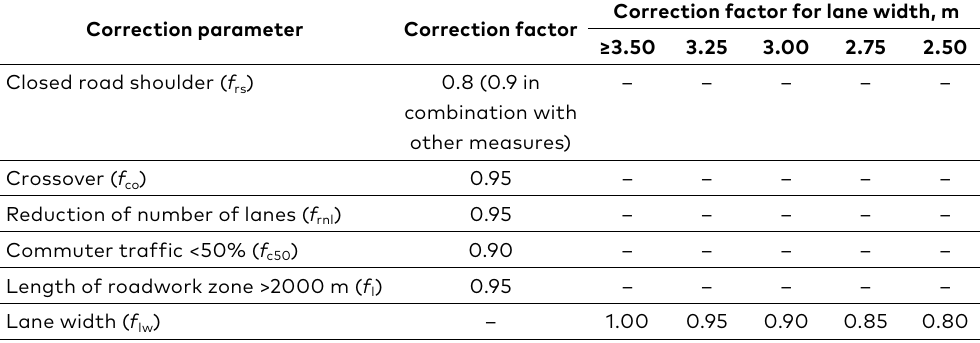
Table 2. Correction parameters for motorways at various roadwork zone designs (BASt, 2011; Vejdirektoratet, 2010) Correction